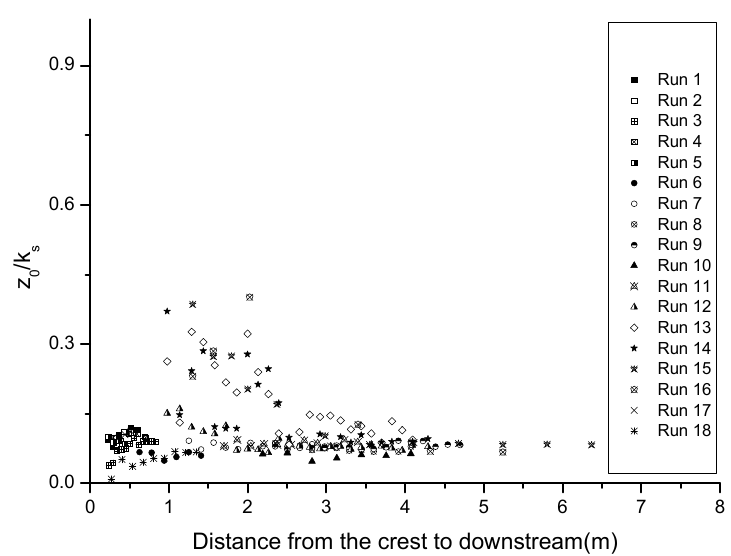
Figure 10. The relationship of z 0 and k s